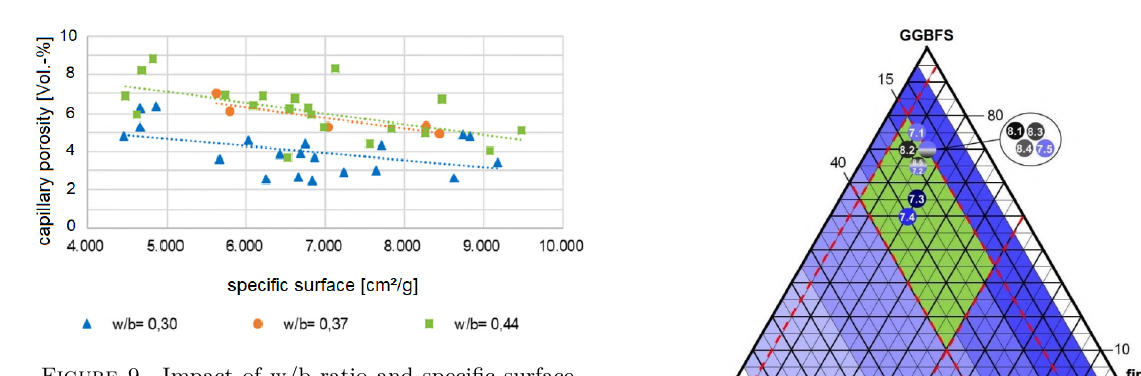
Figure 9. Impact of w/b ratio and specific surface on the capillary porosity.